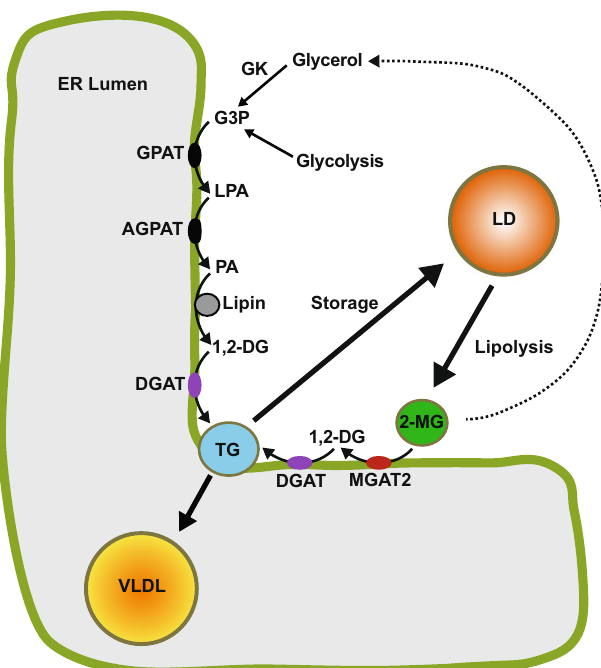
Figure 7. MGAT2 has a role in the lipolysis/re-esterification of stored TG in hepatocytes. TG synthesis at the endoplasmic reticulum begins with glycerol 3-phosphate (G3P) from glycolysis or by the phosphorylation of glycerol by glycerol kinase (GK). G3P undergoes two successive acylation reactions first producing 1-acylglycerol 3-phosphate (LPA) and then phosphatidate (PA) which is dephosphorylated to 1,2-diacylglycerol (1,2-DG). DGAT catalyzes a third esterification reaction producing TG that is stored in cytosolic lipid droplets (LDs) and can subsequently be used for VLDL assembly. VLDL acquire their TG via the